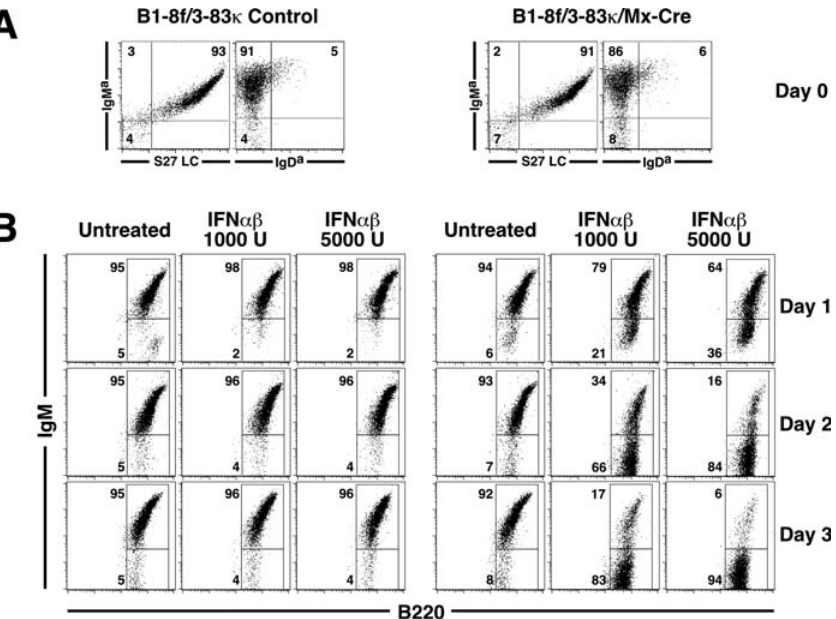
Figure 1. Inducible Cre-Mediated Deletion of the B1-8f HC Allele Leads to Loss of Surface Ig from Immature B Cells (A) Flow cytometry showing surface phenotype of B1-8f/3-83 j and B1-8f/3-83 j /Mx-Cre BM after 5-d IL-7 culture. (B) Flow cytometric analysis of B1-8f/3-83 j and B1-8f/3-83 j /Mx-Cre BM culture cells incubated with IFN ab (1,000 or 5,000 units/ml), in the absence of IL-7, for 1, 2, or 3 d. The cell populations shown are gated on lymphocytes by forward and side scatter, and then for B220. At the end of the 5-d IL-7 culture, more than 90% of the cells were viable and B220 þ . The numbers shown indicate the percentage of gated cells. DOI: